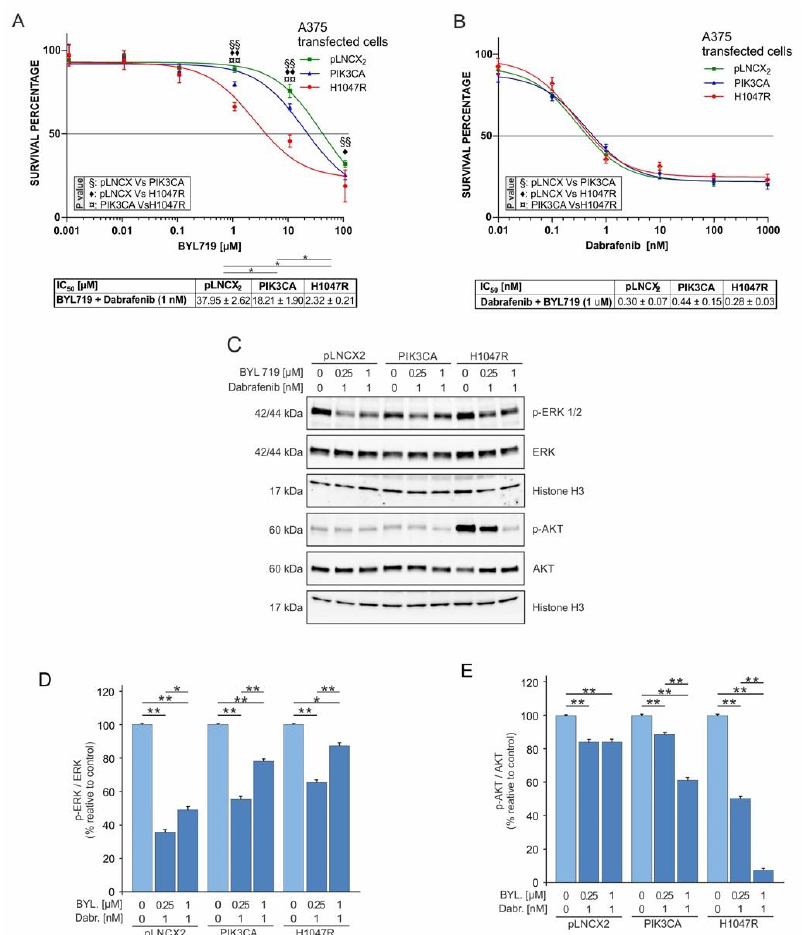
Figure 6. BYL719 and dabrafenib combined treatments of A375 transduced cells. ( A ) MTT assay was performed to evaluate A375 transduced cells’ viability after 72 h of treatment with 1 nM dabrafenib and increasing doses of BYL719 (0.001 to 100 µ M). ( B ) Cell viability (MTT assay 72 h) of A375 transduced cells treated with 1 µ M BYL719 and increasing doses of dabrafenib (0.01–1000 nM). ( C – E ) Western blot analyses of p-ERK, p-Akt, total ERK, and total Akt protein levels evaluated in A375 transduced cells treated for 48 h with 1 nM dabrafenib and growing doses of BYL719 (0.0–0.25–1 µ M). All experiments were performed in triplicate. The statistical significance of the two-tailed Student’s t -test was in reference to the control. * p < 0.05; ** p < 0.01; (cid:117) = p ≤ 0.05; (cid:117)(cid:117) , §§, ¤¤ = p ≤